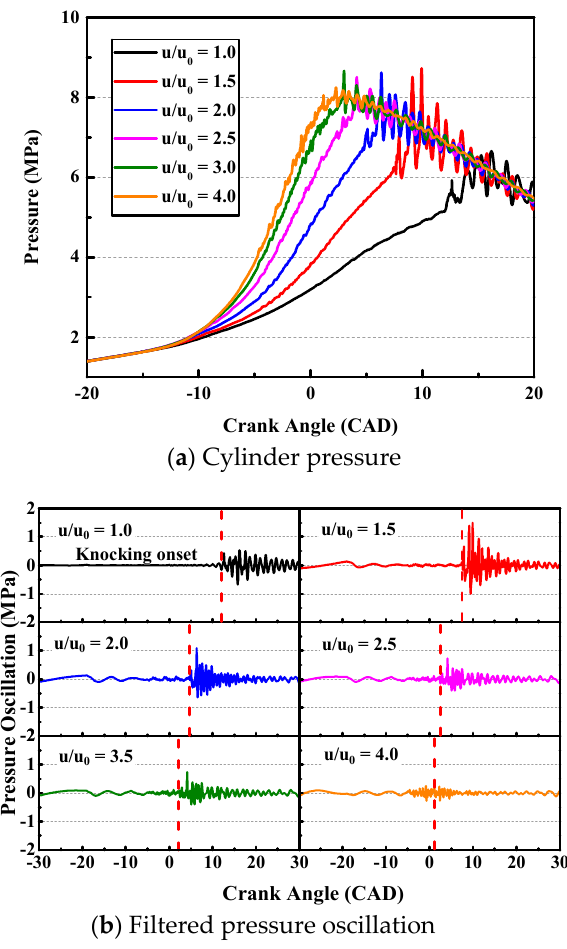
Figure 15. Pressure traces and filtered pressure oscillations with different turbulence intensities.